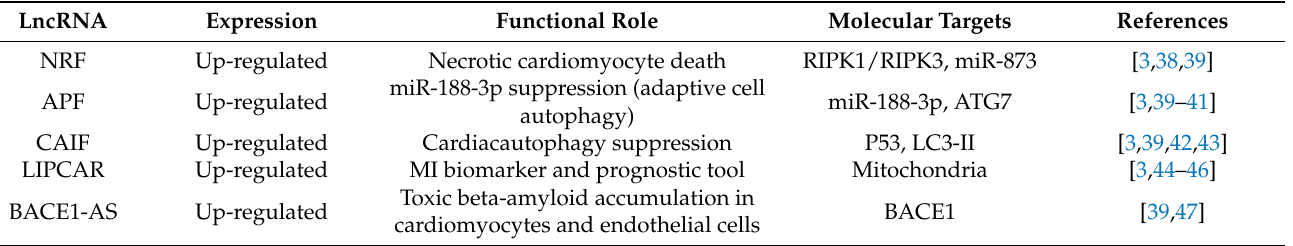
Table 1. Long non-coding RNAs and their function in myocardial ischemia–reperfusion (I/R) injury. LncRNA